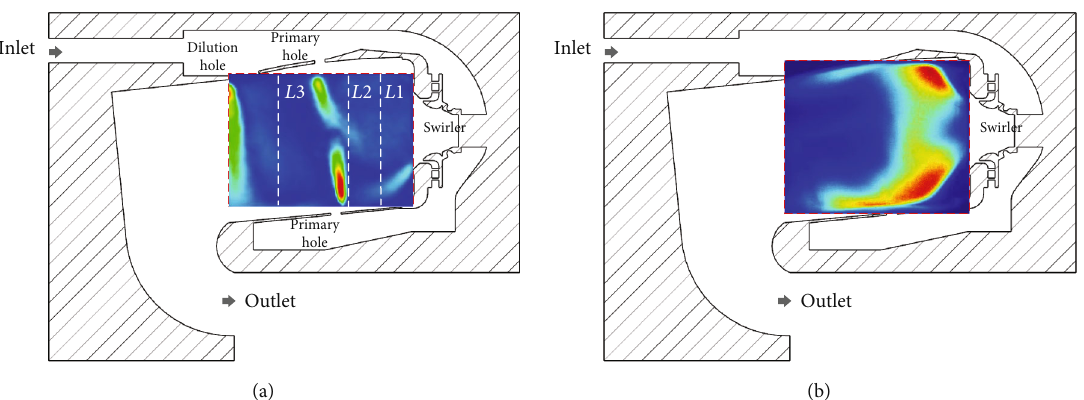
Figure 3: Measurement area of P0 section: (a) cold-state fl ow fi eld experiment and (b) combustion experiment. Table 3: Relevant values of uncertainties in experiments. Parameter Description Error (%) Pressure